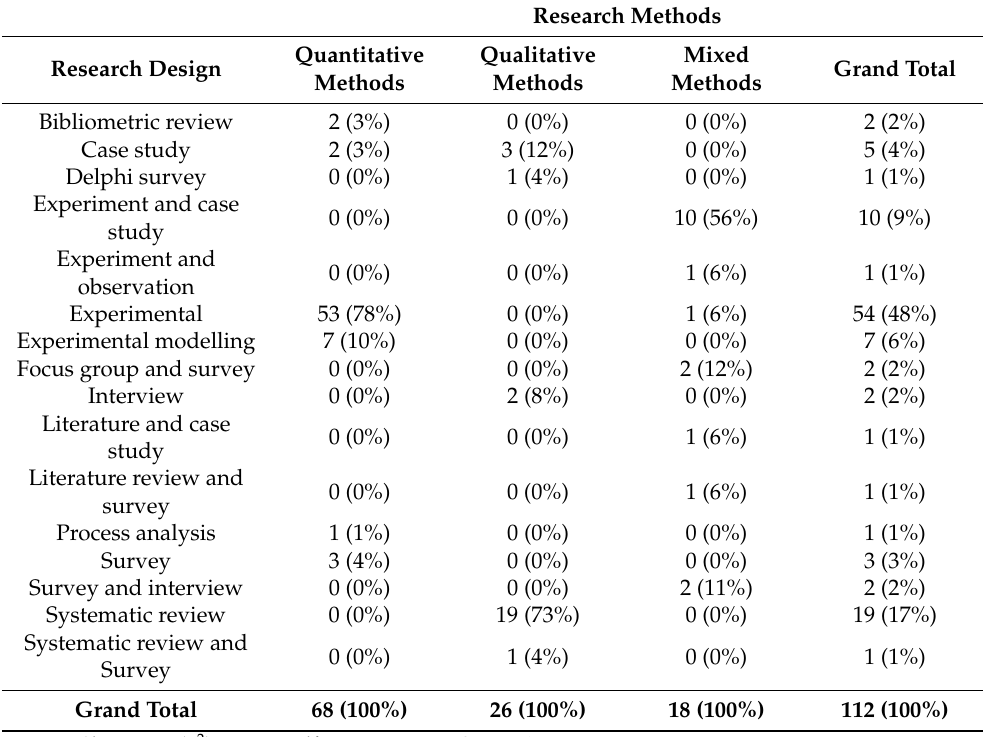
Table 2. Crosstabulation between research methods and research design employed in the construction robotics